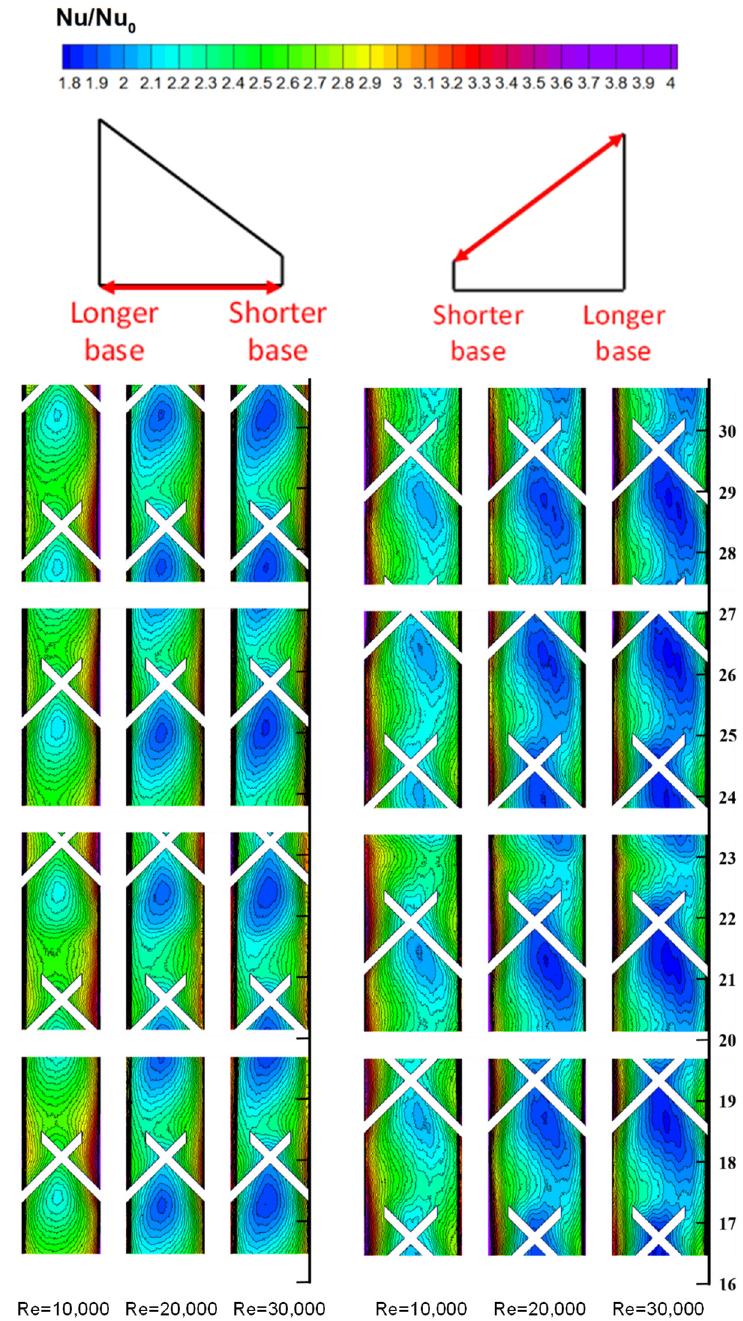
Figure 9. Nusselt number ratios for the downstream cutback X-shaped rib ( P/e = 20).